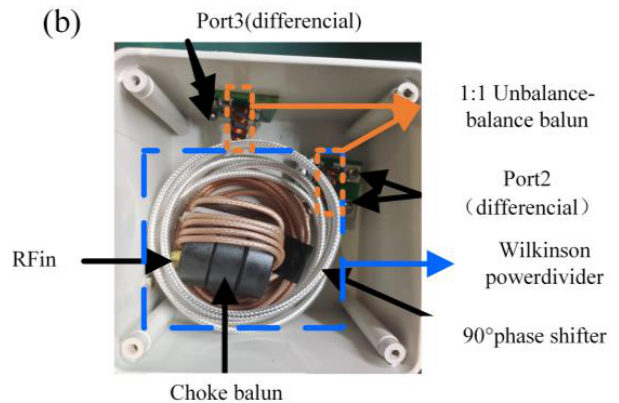
Figure 10. The prototype of the improved feeding network. ( a ) the circuit principal diagram of balun and ( b ) photo of feeding network. Table 3. Statics table of meteor quantity.